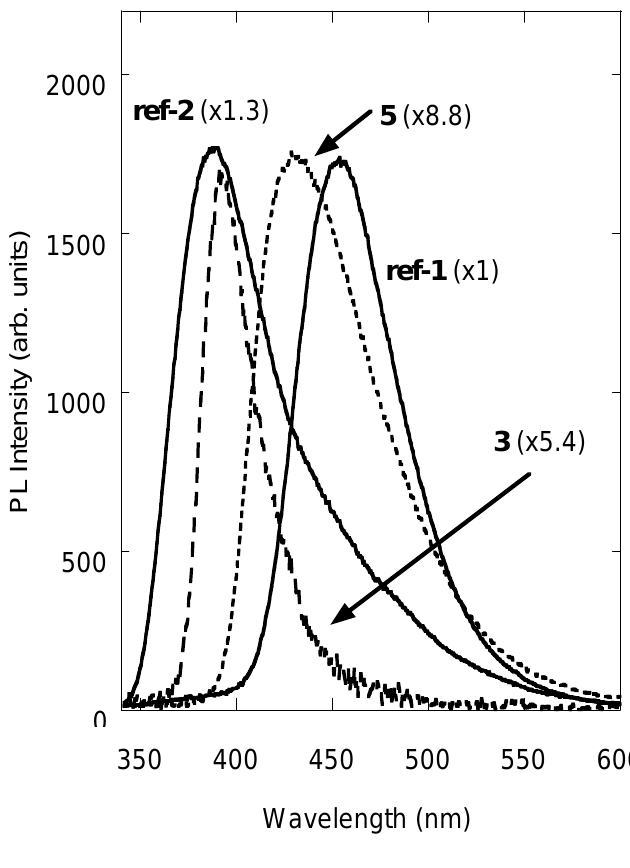
Figure 1. PL spectra of references ( ref-1 and ref-2 ) and coumarin samples ( 3 and 5